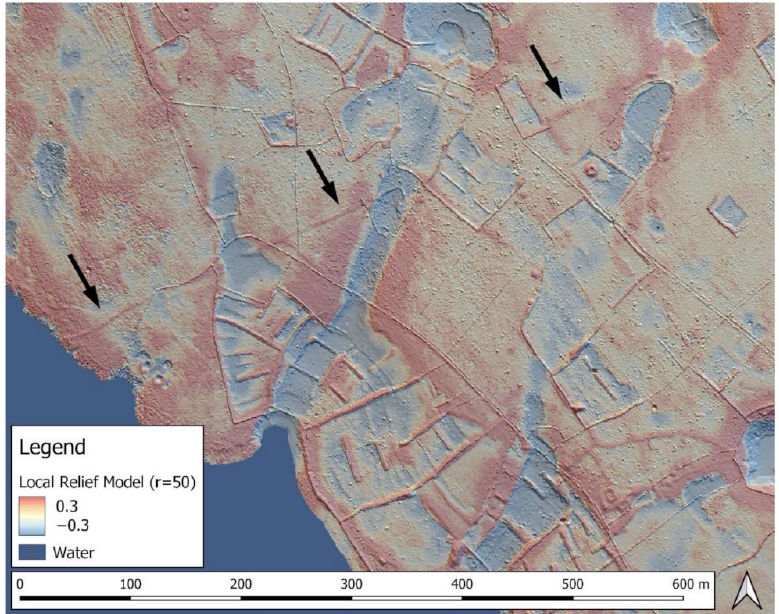
Figure 28. Section of a straight bank (arrows) that may extend to a total length of about 1.000 m shown in the LRM (r = 50) (DFM filtered with “dense_veg” setting) combined with MH (DFM filtered with “stone_wall” setting).